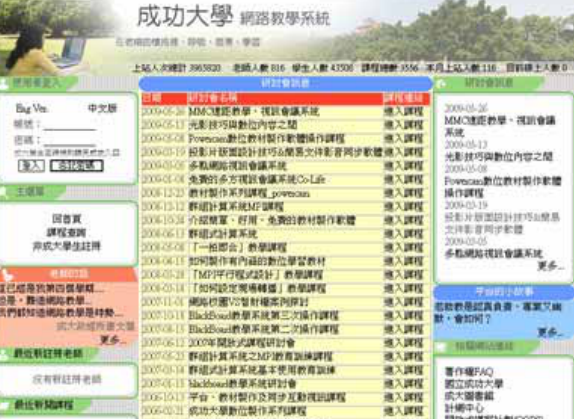
Figure 2. Network teaching related educational training classes